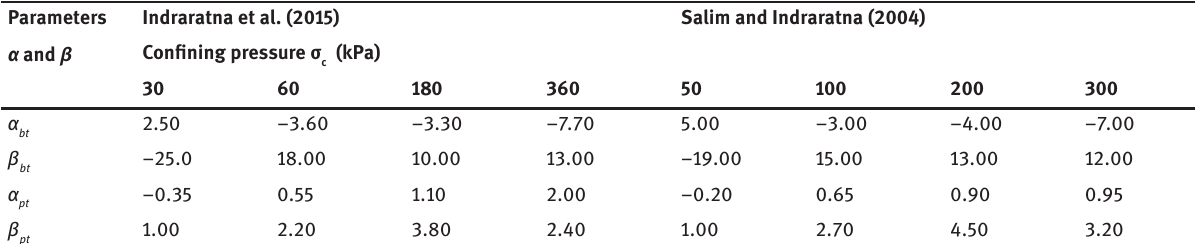
Table 1: The values of α and β for triaxial compression of crushed latite basalt. Parameters Indraratna et al. (2015) Salim and Indraratna α and β